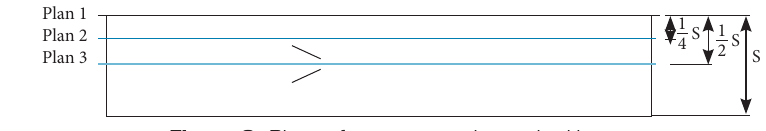
Figure 8. Plans of pressure and speed taking.